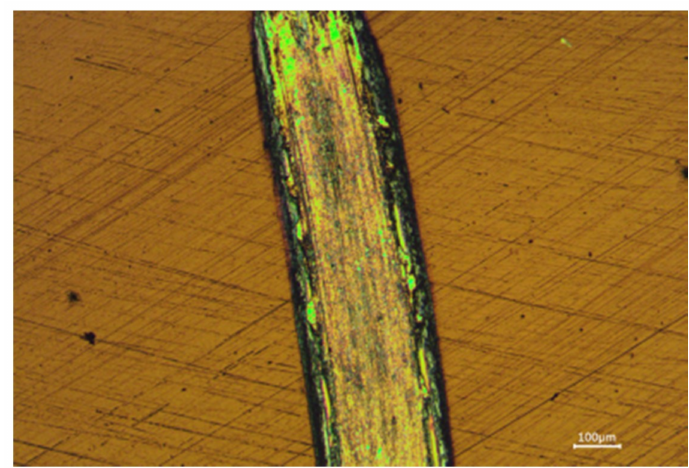
Figure 11. Wear track of DCMS-TiN deposited HSS tested at 300 ◦ C. The wear track of HiPIMS-TiN tested at 300 ◦ C can be referred to in Figure